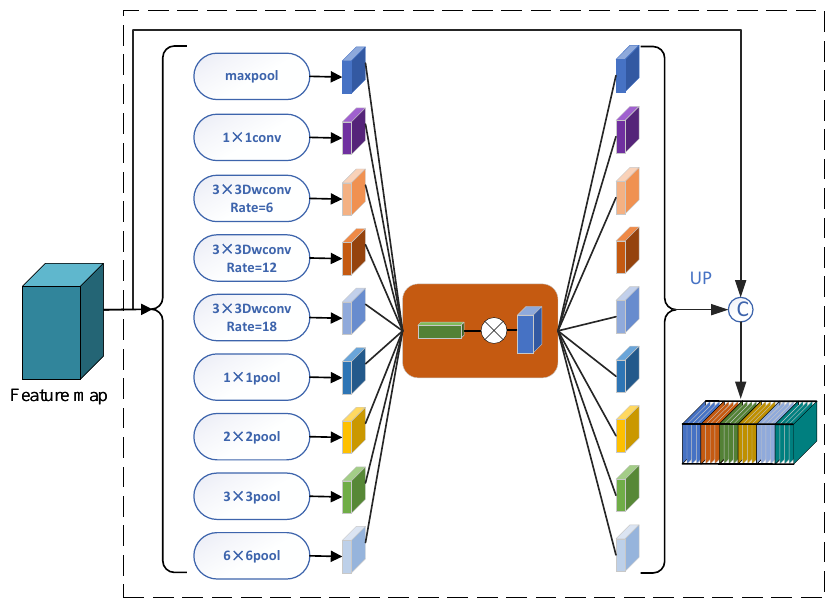
Figure 2. Multi-Scale Feature Extraction Space Pyramid